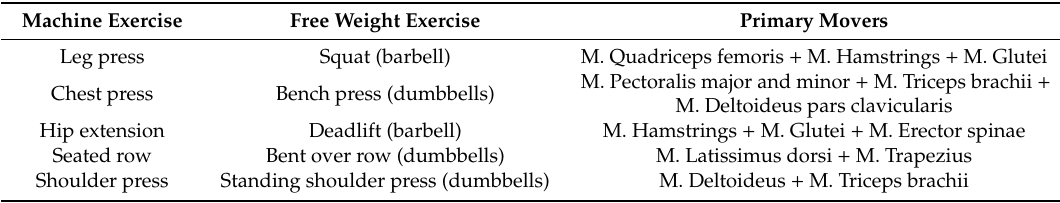
Table 1. Test order and targeted muscle groups for each exercise in the RT program Machine